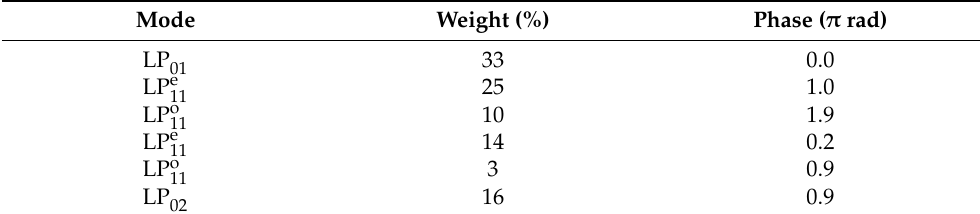
Table 2. Measured modal weights and relative phases to that of the LP 01 mode from the output intensity distribution shown in Figure 9a.